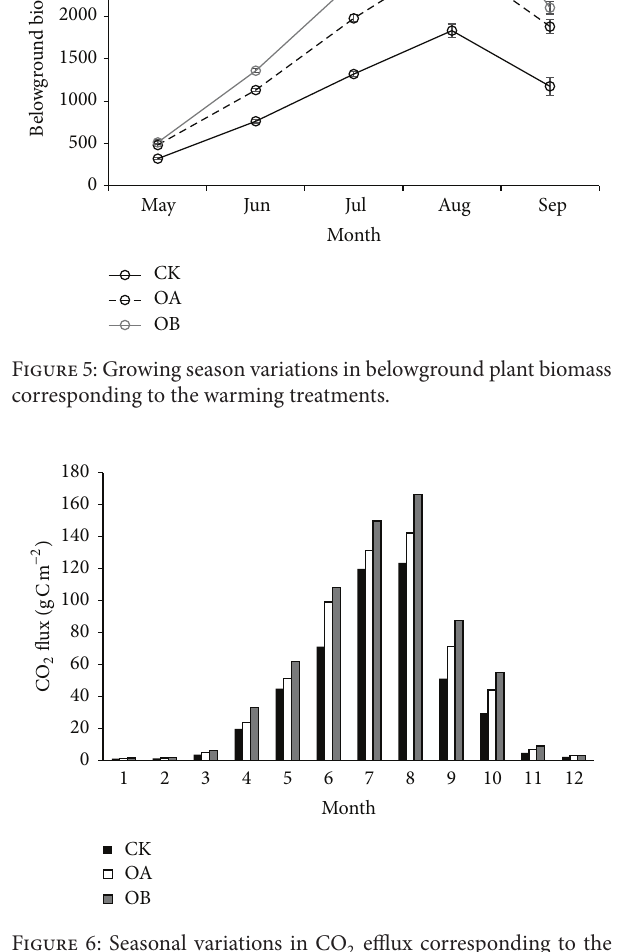
Figure 6: Seasonal variations in CO 2 efflux corresponding to the warming